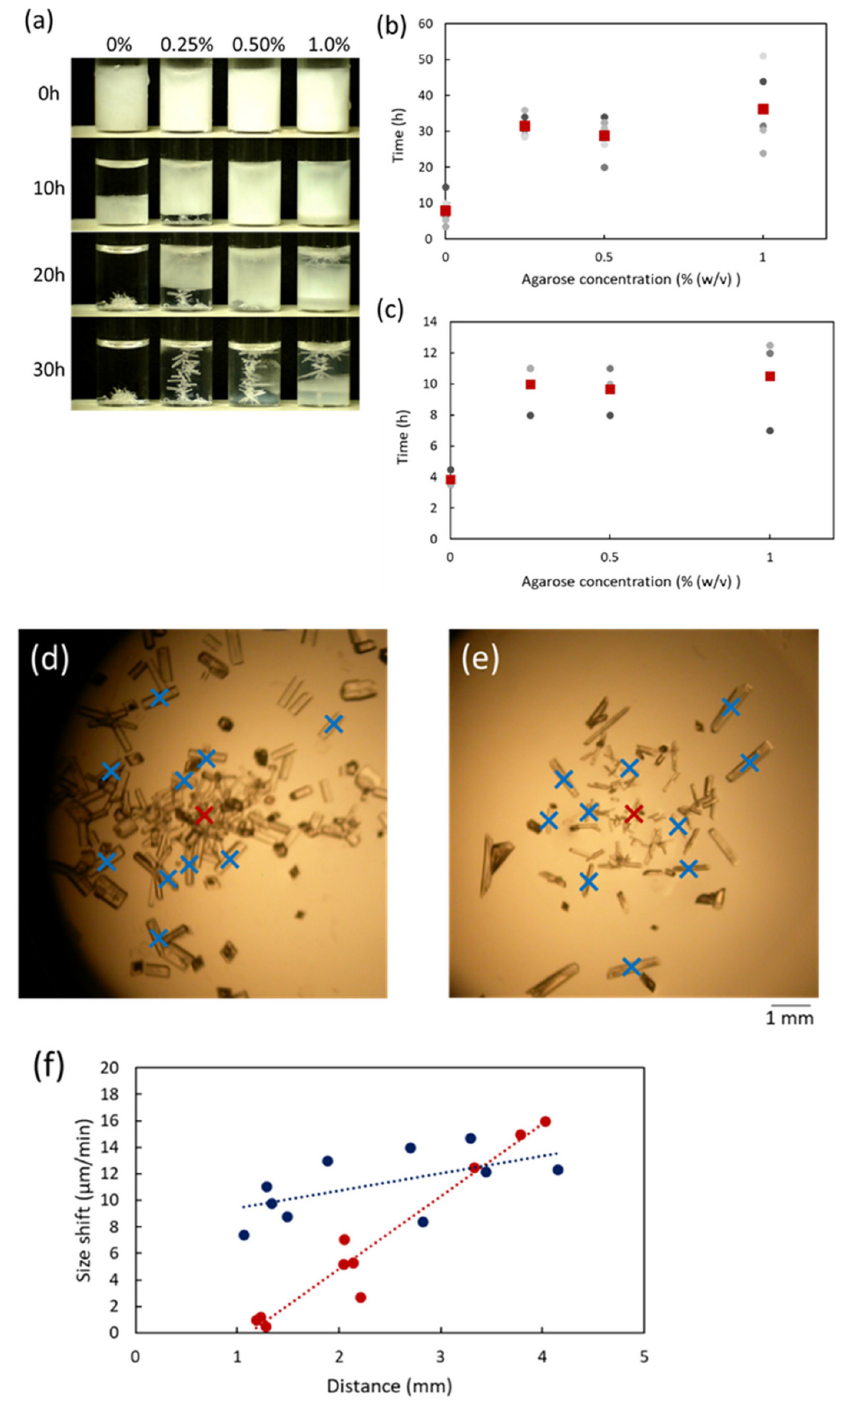
Figure 5. Solution-mediated phase transition from trihydrate to form II by form II seeding in agarose. ( a ) The time profiles in 2.7 mL solutions at 0, 10, 20, and 30 h after seeding from the top. ( b ) Relationship between agarose concentration and average dissolution time of trihydrate in 2.7 mL solution. ( c ) Relationship between agarose concentration and average dissolution time of trihydrate in 0.35 mL solution. ( d , e ) Form II crystals after the solution-mediated phase transition in the presence (1.0% ( w / v )) ( d ) and absence ( e ) of agarose. The red crosses indicate the seeding sites, and the blue crosses indicate the size-measured form II crystals. ( f ) The crystal size shift (long side) of form II crystals as a function of the distance from the seeding site. Blue and red circles represent the crystals in the absence and presence (1.0% ( w / v )) of agarose,